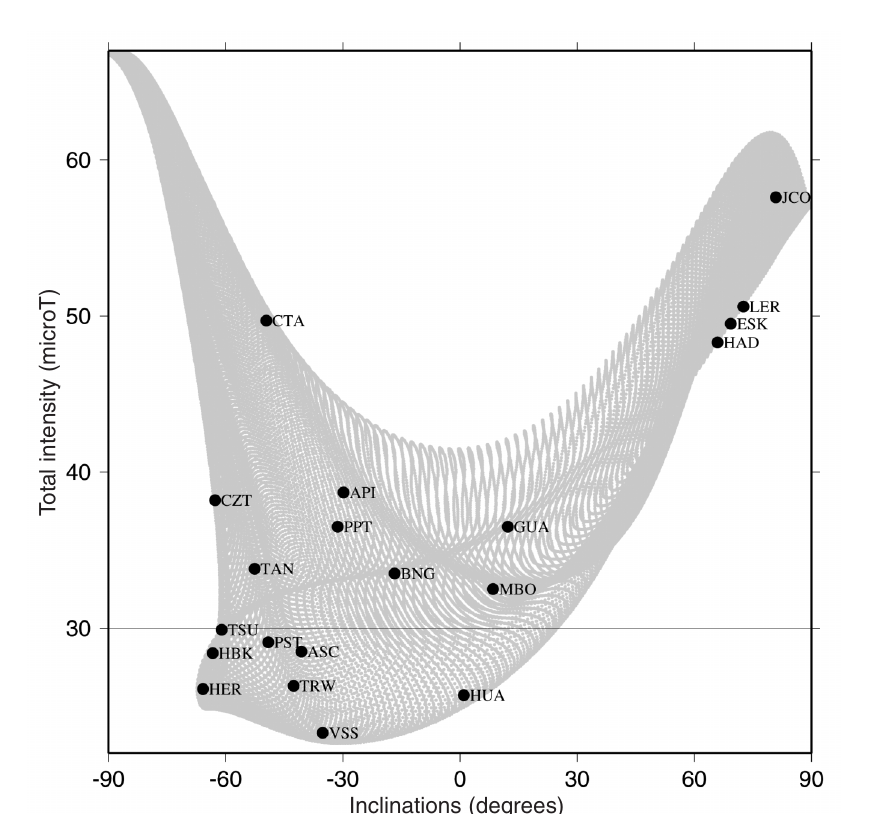
Fig. 7. Locus of modelled values of inclination and total intensity from the 10th generation IGRF at 2005.0 for the whole of the Earth’s surface and for the observatories whose minute means and 1-second values were used in this study. Below the 30 µ T line indicates region of the SAA. If the field was dipolar the locus would be a